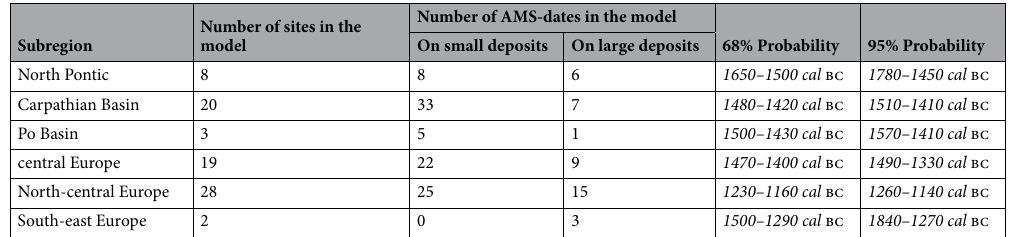
Table 2. Estimated dates for the start of millet cultivation in each subregion, given by the Bayesian chronological model (Supplementary Text 1, 2) and shown in Figs. 4, 5.